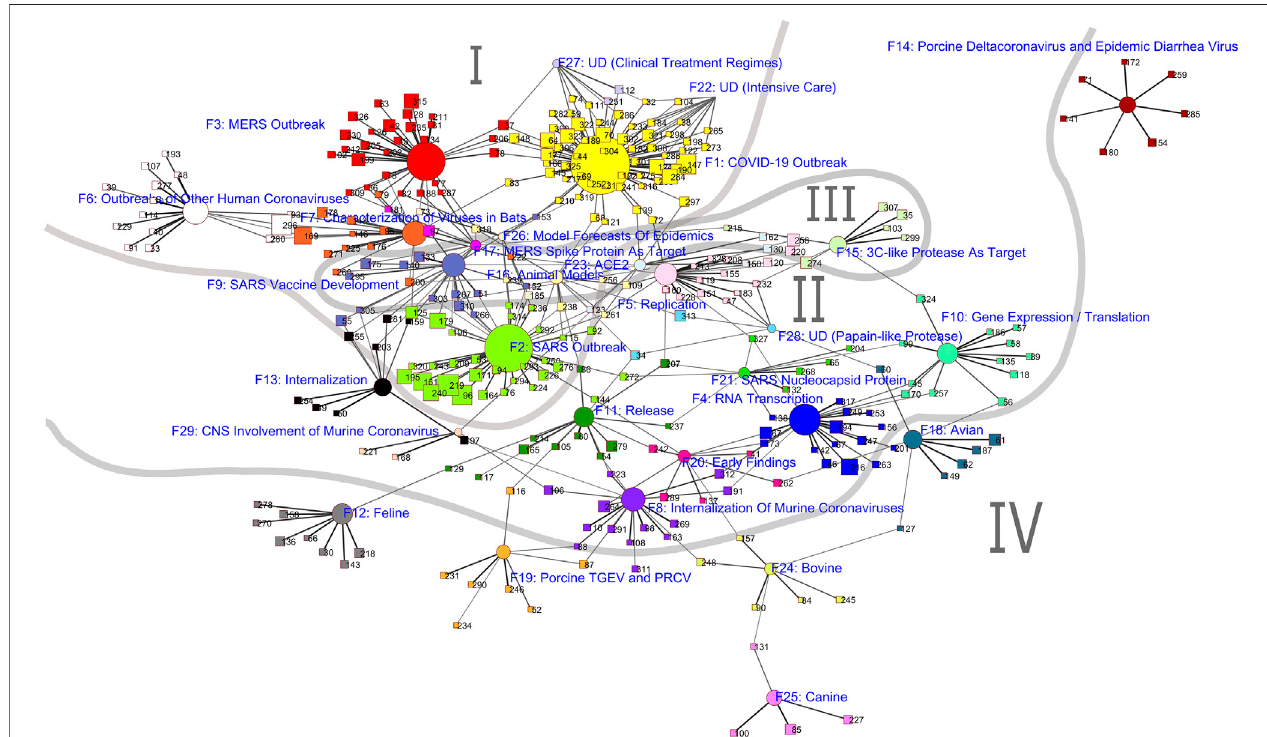
FIGURE 1 | Visualization of the intellectual structure of research on